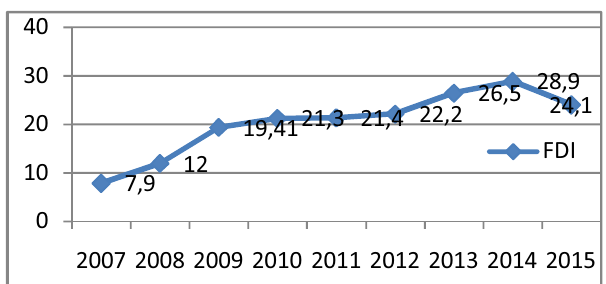
Fig. 1. The dynamics of FDI in Kazakhstan from 2007 to 2015, billion US dollars Note: compiled by the author based on statistics of the National Bank of